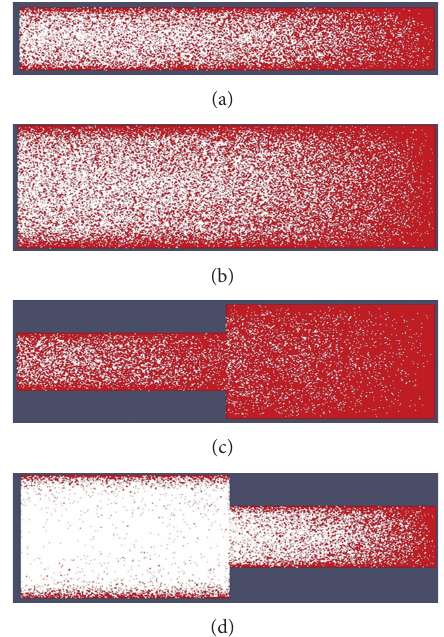
Figure 5: Molecule distributions at 0.00084 s for cases “small” (a), “big” (b), “small-big” (c), and “big-small” (d). All geometries were scaled by a factor of 100 in the flow direction.